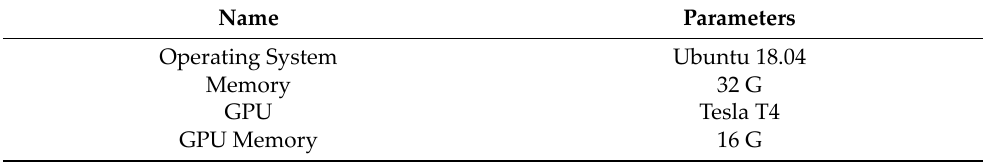
Table 1. Experimental